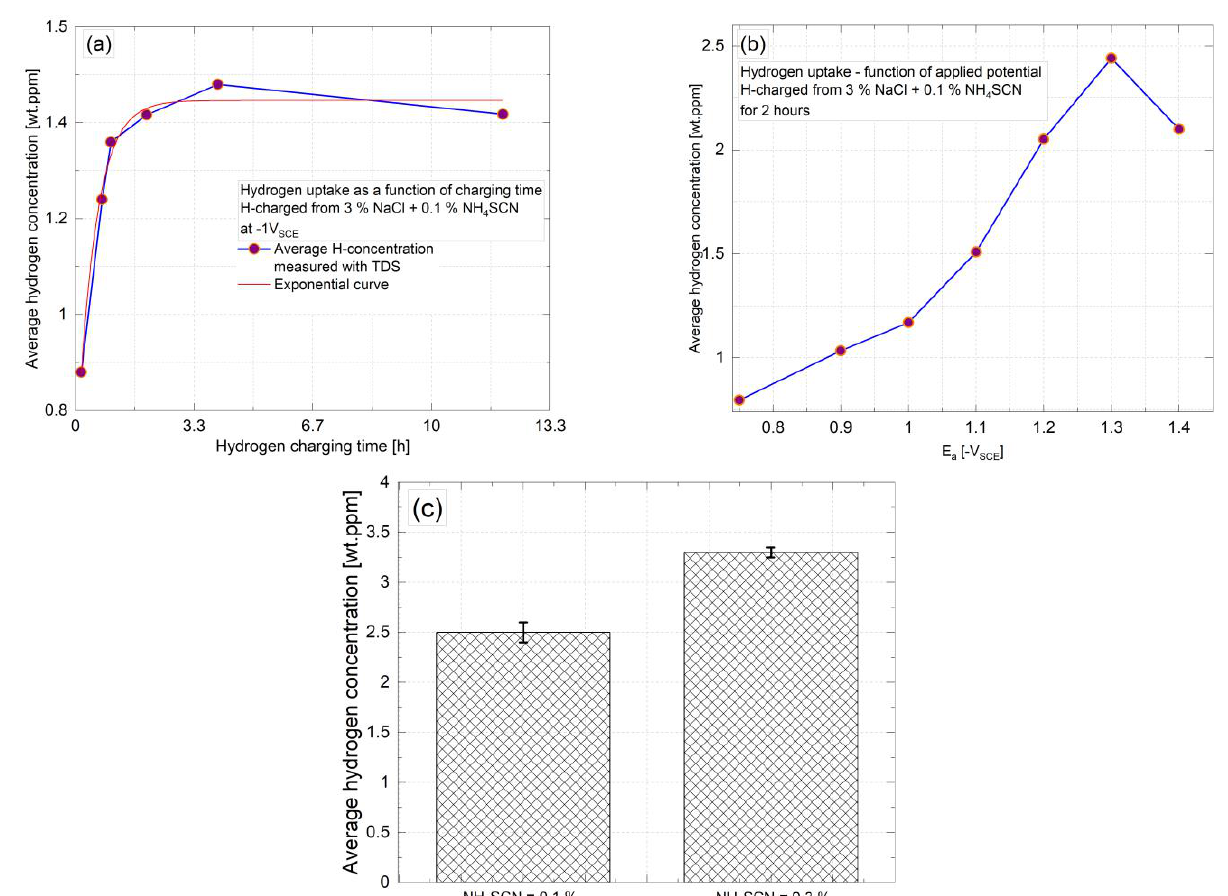
Figure 4. ( a ) Measured hydrogen concentration as a function of hydrogen charging time; ( b ) measured hydrogen concen- tration as a function of applied electrochemical potential; ( c ) effect of NH 4 SCN concentration on the measured hydrogen concentration after hydrogen charging for 2 h at the applied potential of −1.2 V SCE .